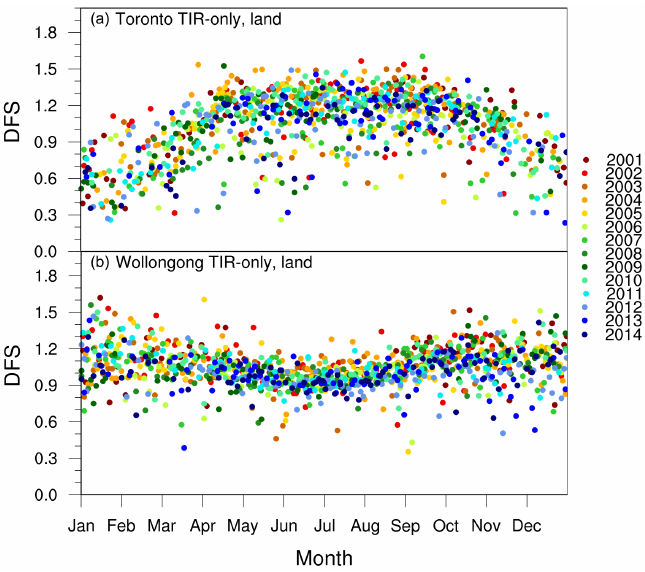
Figure 3. Seasonality of daily mean MOPITT DFS (TIR-only) within a 1 ◦ radius at the Northern Hemisphere station of Toronto (a) and Southern Hemisphere station of Wollongong (b) .